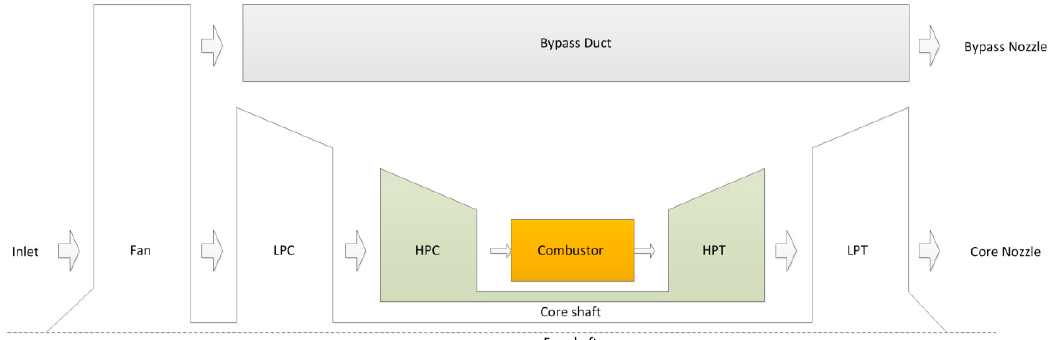
Figure 1. Schematic description of two-spool turbofan engine.